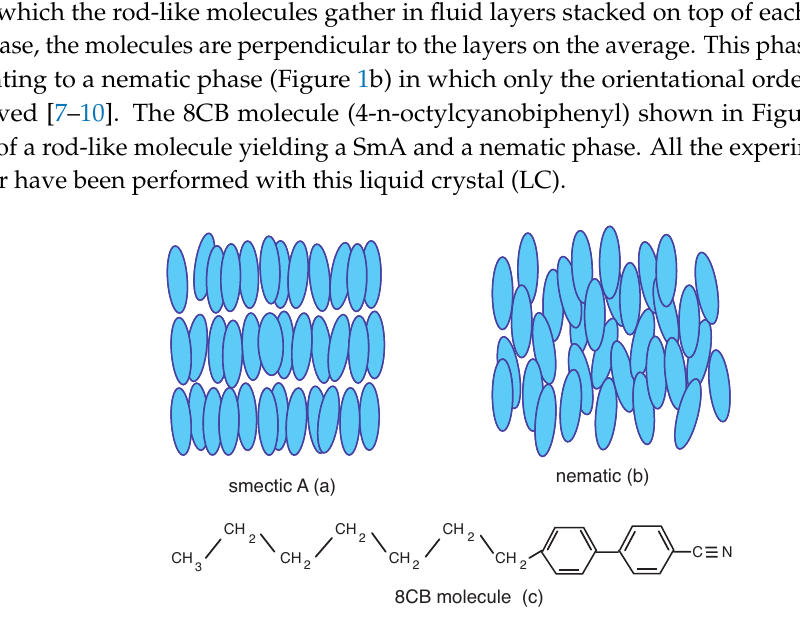
Figure 1. ( a ) structure of the smectic A phase; ( b ) structure of the nematic phase; ( c ) 8CB molecule exhibiting a smectic A phase between 21 and 33.3 ◦ C and a nematic phase above 33.3 ◦